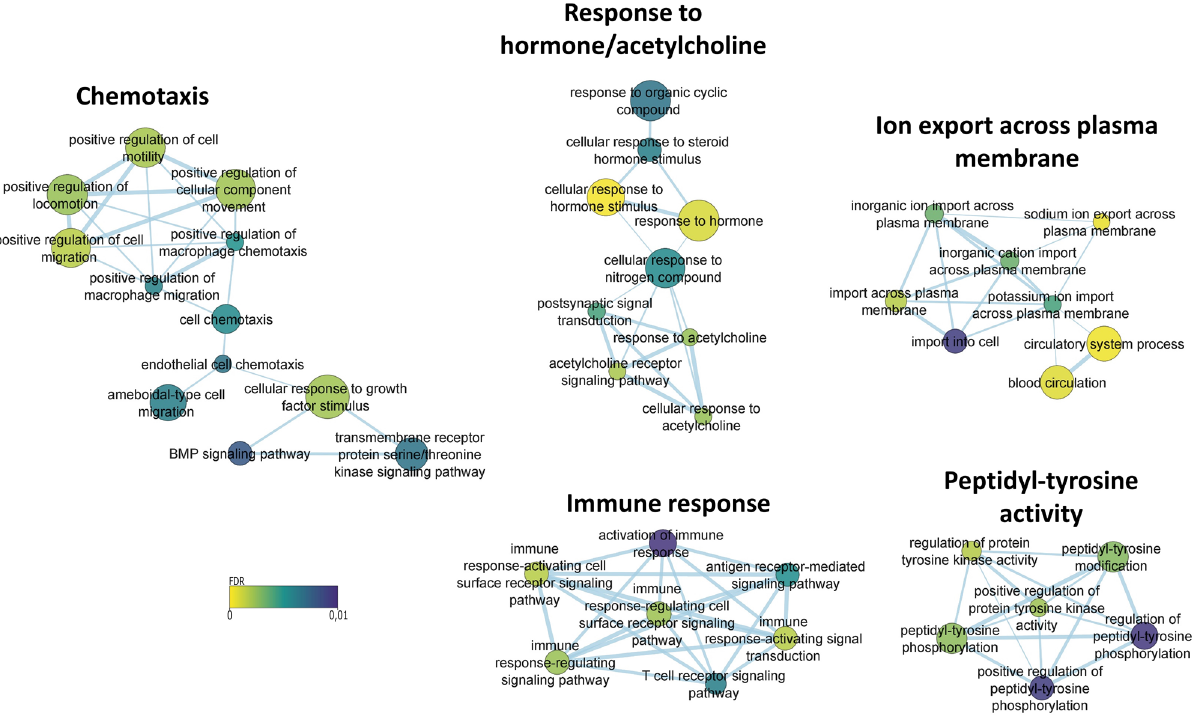
Figure 2. Enriched GO terms from the biological process category among the 75 most expressed miRNAs in spleen samples. Node size represents the number of targets in the term; edge size represents the number of targets that overlap between terms; node colour represents the significance level (adjusted p-value by the Benjamini–Hochberg